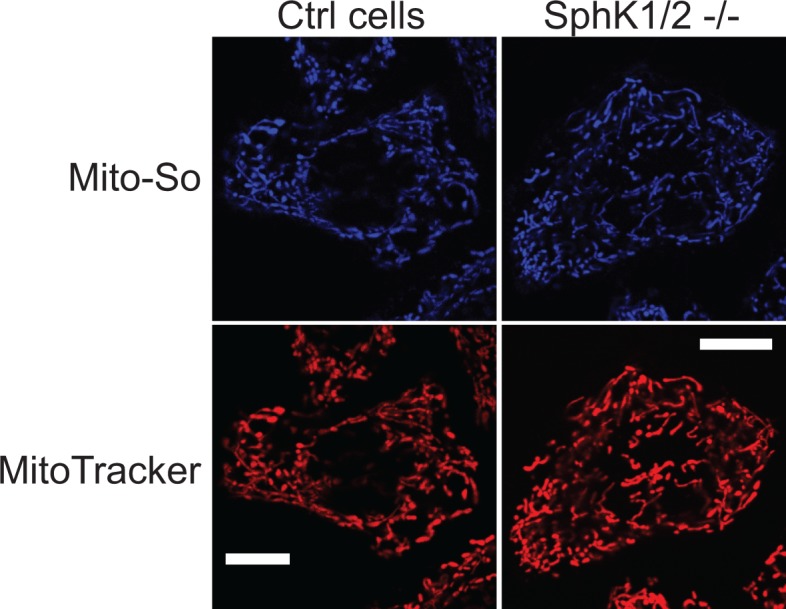
Fluorescence images of Mito-So in SphK KO cells.Representative fluorescence images of sphingosine kinase knockout cells stained with Mito-So (5 μM) and MitoTracker (50 nM) following procedures described in the materials and methods. Scale bar: 10 μm.